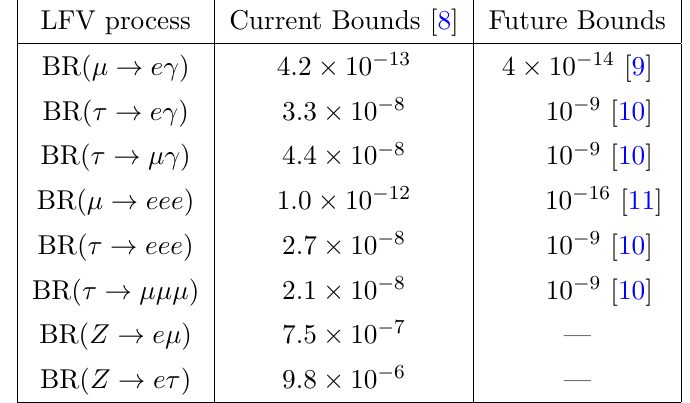
Table 1 . Relevant Lepton Flavour Violating (LFV) processes considered in our analysis. with b ’ 2 c = (1 + c ) and b ’ 2 c = (1 + c 2 ). Thus, as stated before, when 1 1 1 2 2 1